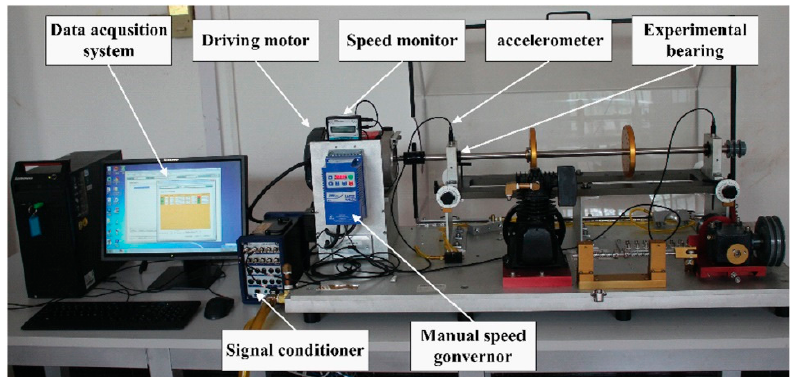
Figure 6. Machinery Fault Simulator Magnum (MFS-MG) fault simulation test bench.